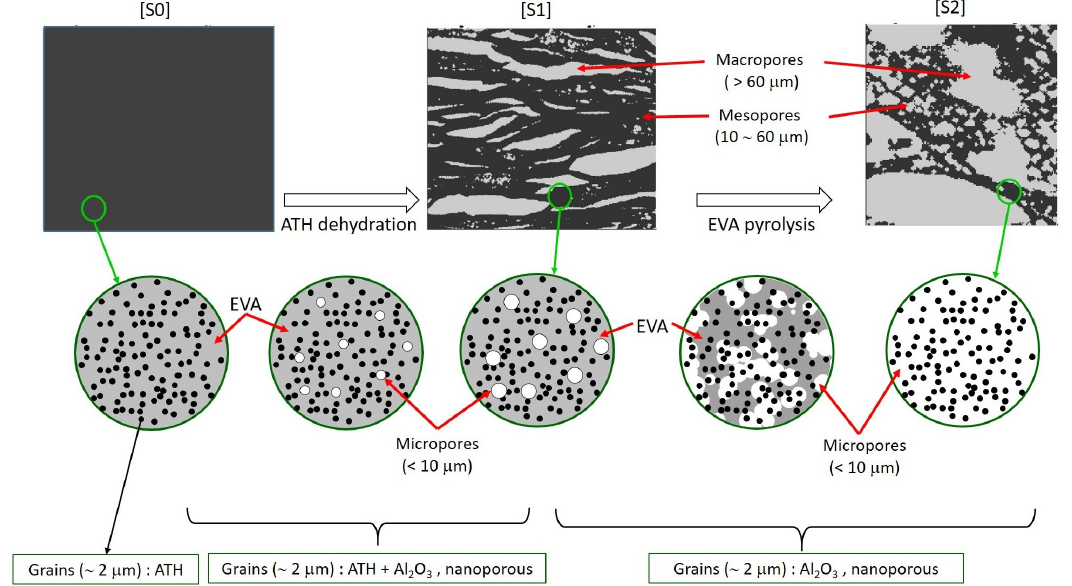
Figure 4. Multiscale structure of the material in its successive states [S0], [S1] and [S2] (left to